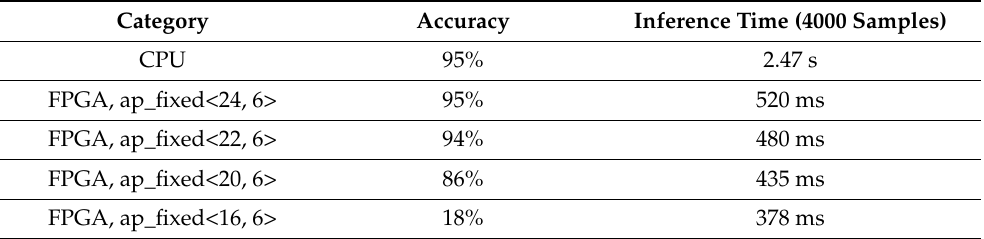
Table 1. Comparison of accuracy for test data and response speed between CPU and FPGA. Category